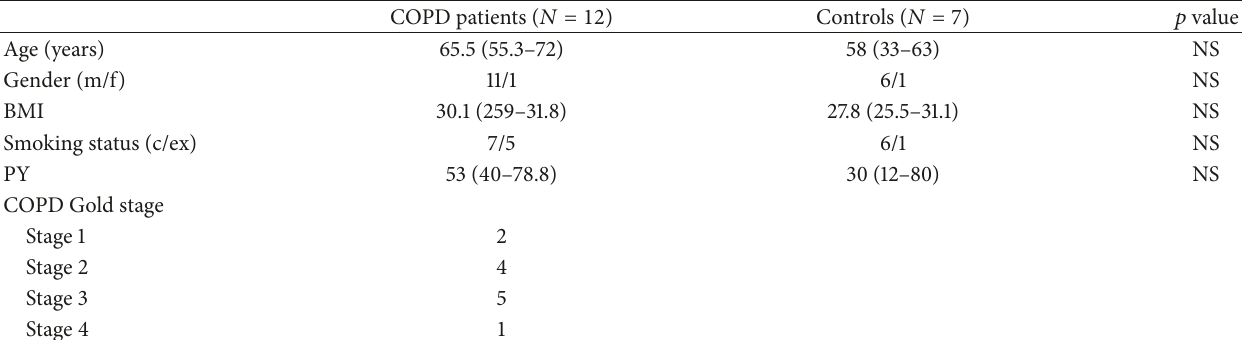
Table 2: Patient’s demographic data.